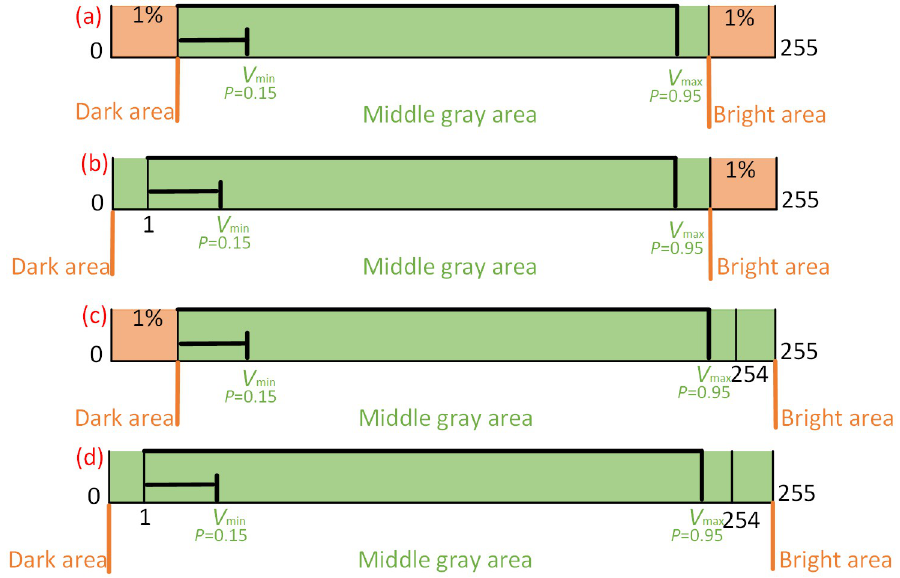
Fig 3. Upper and lower boundaries of middle gray area. (a) Unsaturation; (b) Negative saturation; (c) Positive saturation; (d) Negative and positive saturation.